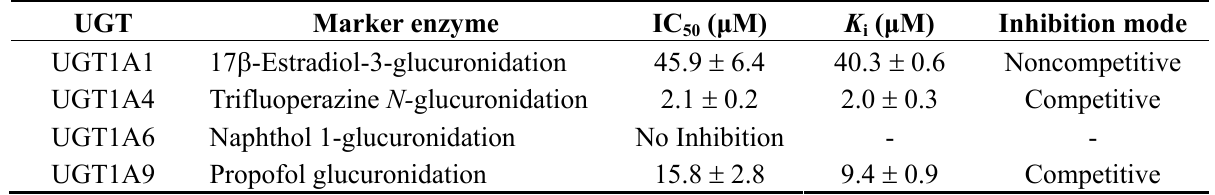
Table 1. Effect of efavirenz on UGT metabolic activity in pooled human liver microsomes